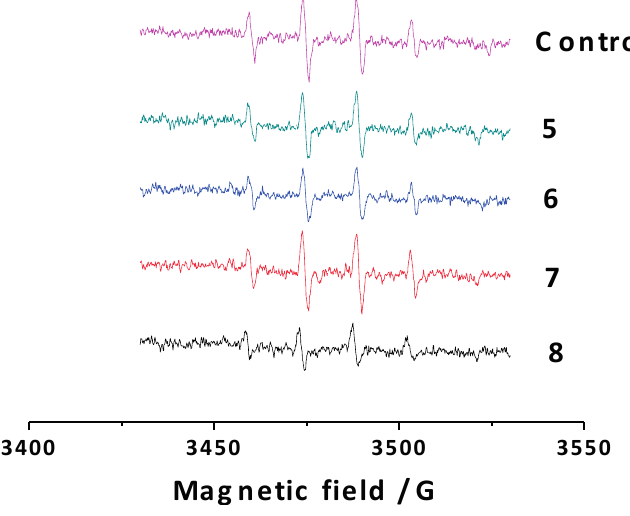
Figure 4. Spectrogram of the adduct formed between AAPH-derived radical by photolysis and DMPO. G-value: 2.0023. Microwave frequency: 9.81 GHz, Modulation amplitude: 0.95 G, Time constant: 81.92 ms, Conversion time: 40.96 ms. Simple LW =